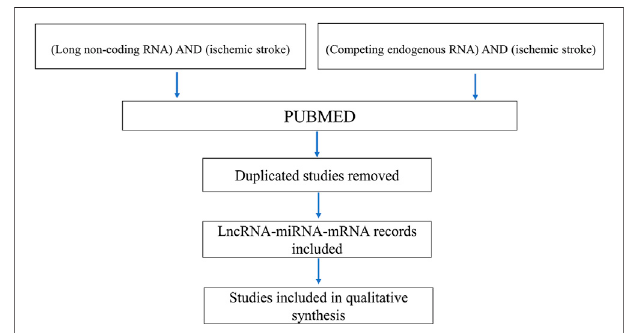
FIGURE 2 | Article selection